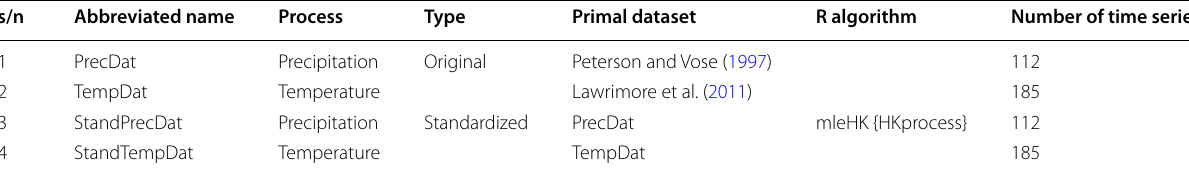
Table 2 Datasets of this study (part 1): real-world datasets